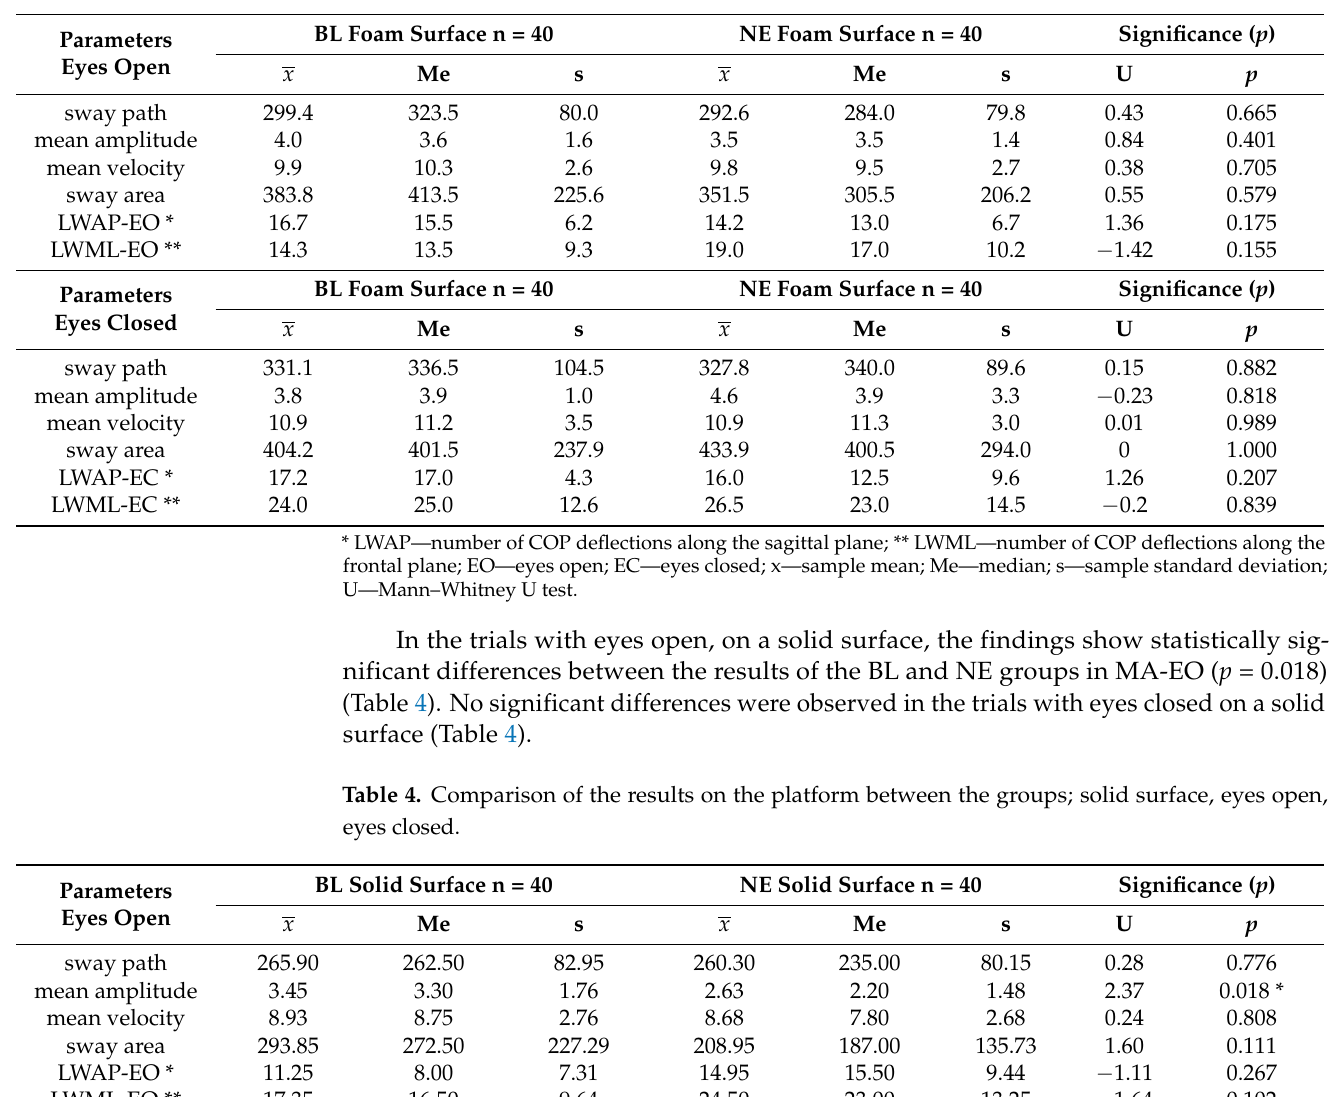
Table 3. Comparison of the results on the platform between the groups; foam surface, eyes open and eyes closed.